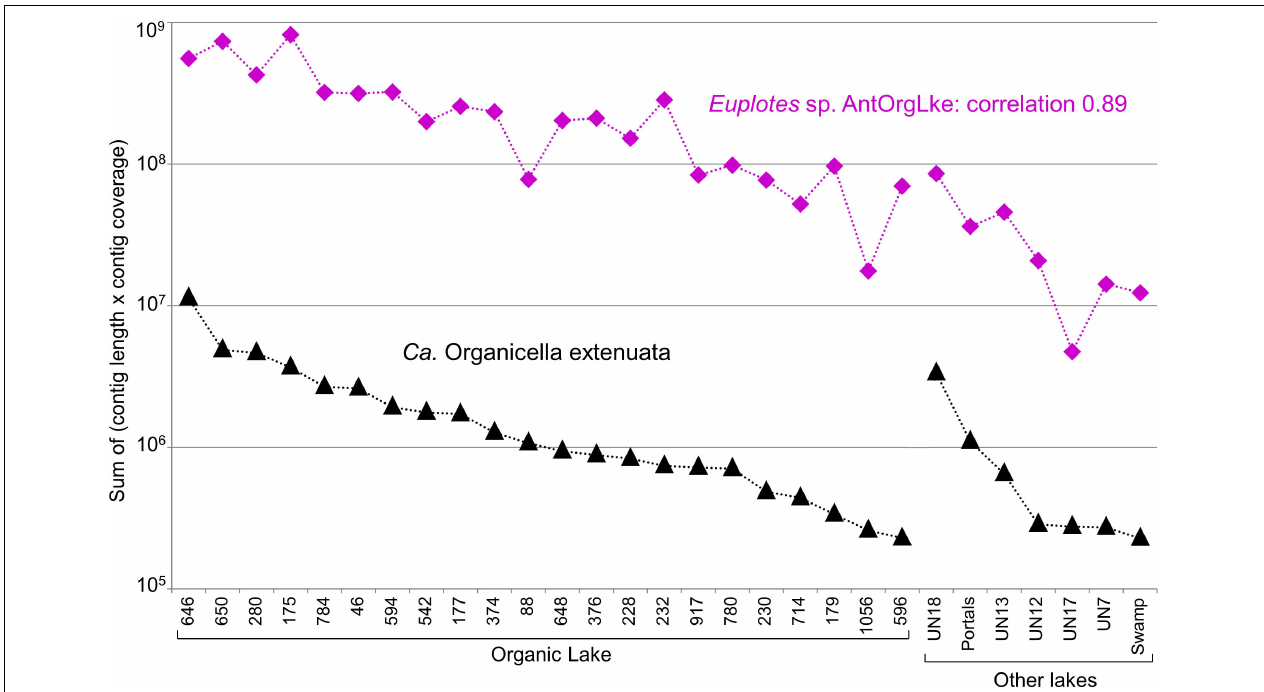
FIGURE 2 | Co-occurrence of Candidatus Organicella extenuata and Euplotes sp. AntOrgLke in Antarctic metagenomes. The abundance of Ca. Organicella extenuata (k141_311079) and Euplotes sp. AntOrgLke (bin81 + bin14 + contigk141_859071), calculated as the sum of (contig length × contig coverage) for all contigs, was analyzed using SparCC to determine their co-occurrence ( r, correlation coefficient). Across 29 metagenomes in which Ca. Organicella extenuata was detected, the abundance of Euplotes sp. AntOrgLke strongly positively correlated with the abundance of Ca. Organicella extenuata ( r = 0.89, p = 0), indicating Euplotes sp. AntOrgLke was likely the host of Ca. Organicella extenuata. None of the other 187 bins representing other potential hosts exhibited a positive correlation above r = 0.54. X -axis labels: Organic Lake, metagenome IDs (see Supplementary Table 5 ); Other lakes, lake names (Unnamed abbreviated as